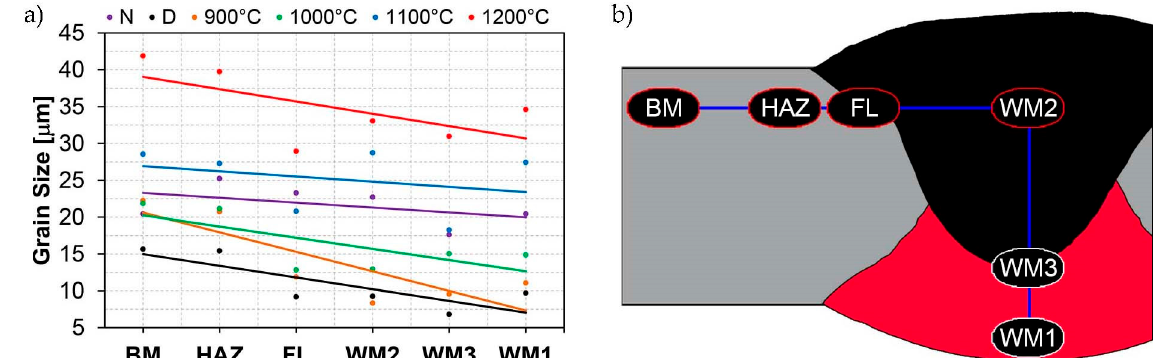
Figure 65. Change in average grain size of the prior austenite for different austenitising temperatures ( a ), determined in characteristic zones of the welded joint of Hardox 450 steel, running along the line schematically shown in Figure ( b ). N—normalised state, D—delivery state (directly after welding), BM—parent material, (FG)HAZ—heat-affected zone (fragmented grain), FL—fusion line, WM—melt material zones.)